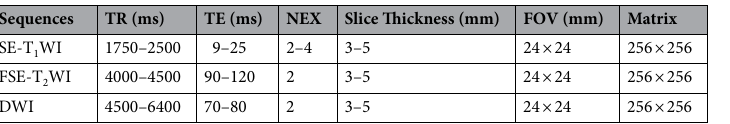
Table 1. MRI protocol. SE spin echo, FSE fast spin echo, TR repetition time, TE echo time, NEX number of excitations, FOV field of view, DWI diffusion-weighted imaging.